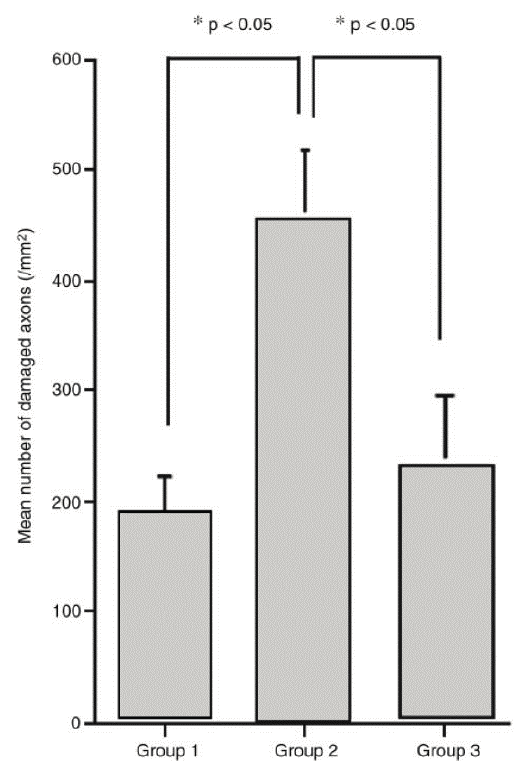
Figure 6. This bar graph shows a comparison of the numbers of amyloid precursor protein (APP) immunoreactive axonal profiles in the pontomedullary junction in three different treatment groups. Group 1 animals were subjected to traumatic brain injury (TBI) followed by 1 h of hypothermia and slow rewarming. In contrast, Group 2 animals were subjected to TBI and the same hypothermic intervention followed by rapid rewarming. Group 3 animals were also subjected to TBI followed by hypothermia and rapid rewarming with the concomitant infusion of cyclosporine A (CsA). Note that Group 1 animals showed a reduced burden of axonal damage associated with the use of hypothermia and slow rewarming, whereas these axonal numbers were dramatically increased following the same insult and hypothermic intervention, now with the inclusion of a rapid rewarming